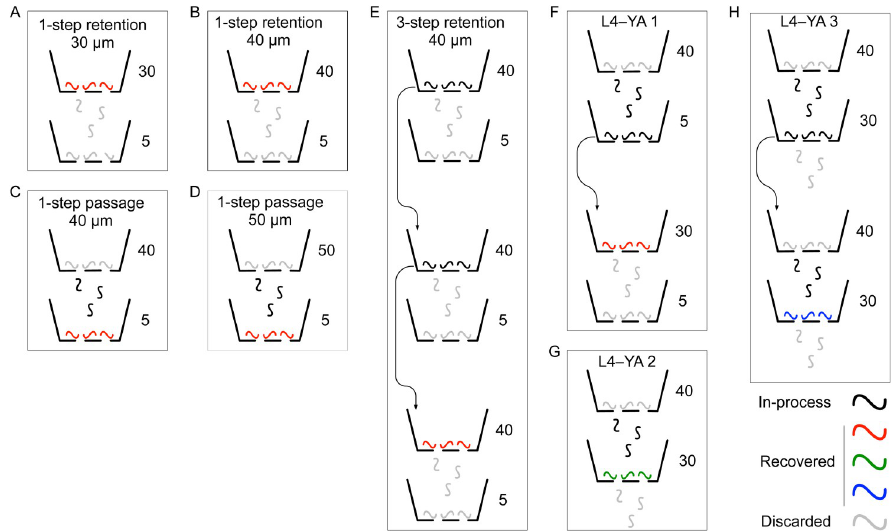
Fig 2. Flow charts of the eight size-sorting filtration protocols tested in this study. Numbers next to strainer icons indicate mesh size ( μ m). Worm symbols are color coded according to phase in the filtration process as shown in the key. Arrows indicate successive filtration steps, as defined in Materials and Methods. Although not strictly necessary, the 5 μ m filters in 1-step retention, 30 μ m and 1-step retention, 40 μ m were included for consistency with the 1-step passage, 40 μ m and 1-step passage, 50 μ m